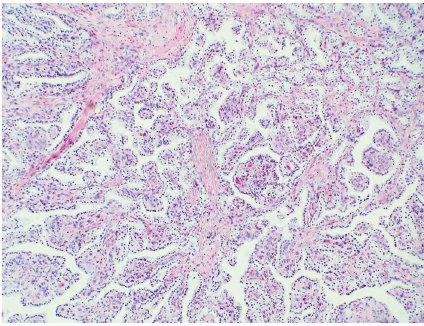
Figure 2: Papillary portion of nodule adjacent to left fallopian tube.